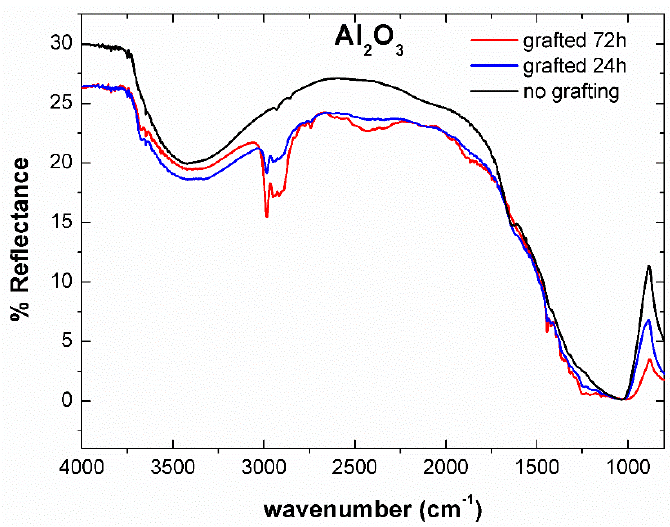
Figure 5. DRIFTS spectrum of the alumina powders before and after grafting with FAS.